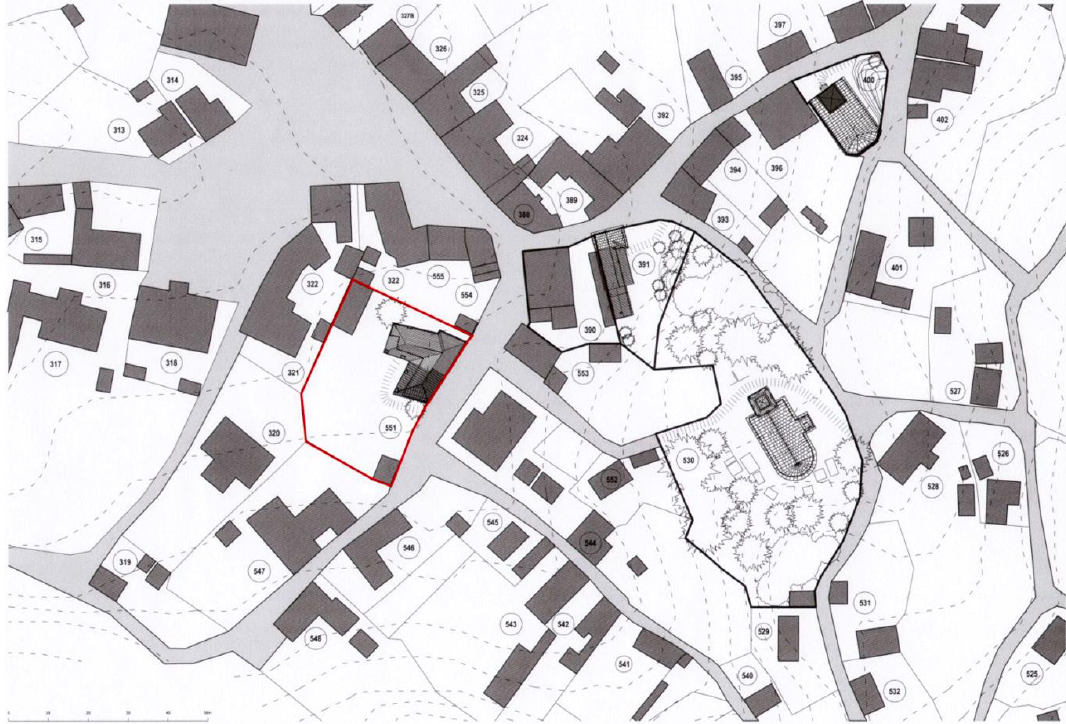
Figure 1: Central area of Roşia Montană. Red delimitation of the Reformed Parsonage Source: Apostol & Bâlici 2010, plate no.